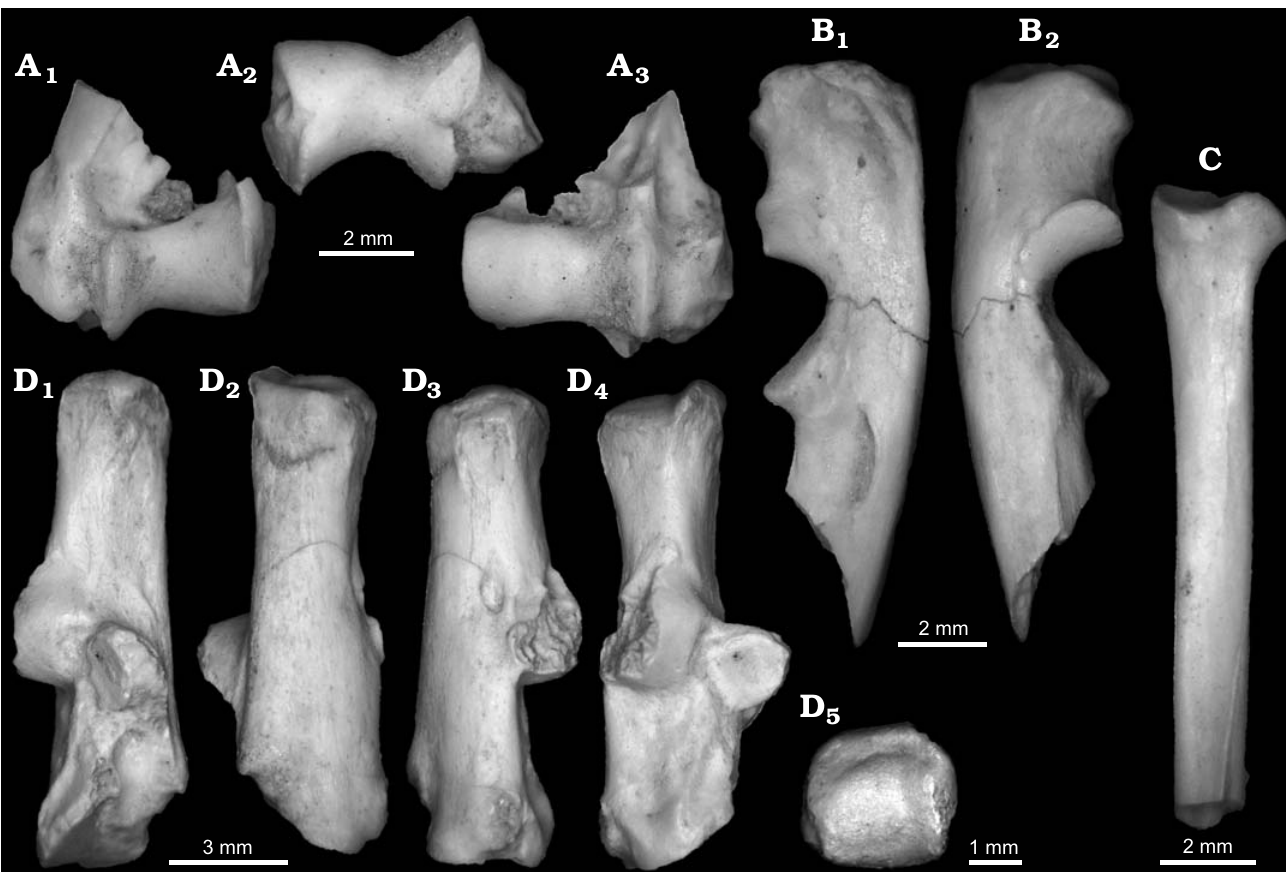
Fig. 11. Limb bones of the lagomorph Gobiolagus aliwusuensis Fostowicz-Frelik, Li, Meng, and Wang, 2012 from the Eocene of Wulanhuxiu, Nei Mongol, China. A . Distal part of left humerus (IVPP V20265.19) in ventral (A 2 ), cranial (A 1 ), and caudal (A 3 ) views. B . Proximal part of right ulna (IVPP V20265.21) in medial (B 1 ) and lateral (B 2 ) views. C . Proximal part of radius (IVPP V20265.20) in cranial view. D . Right calcaneus (IVPP V20265.22) in medial (D 1 ), plantar (D 2 ), lateral (D 3 ), dorsal (D 4 ), and caudal (D 5 )